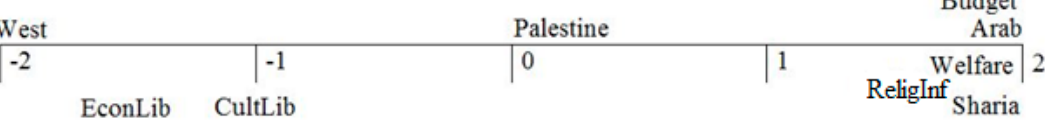
Figure 8. Ideological structure of Egyptian issues, 1987.